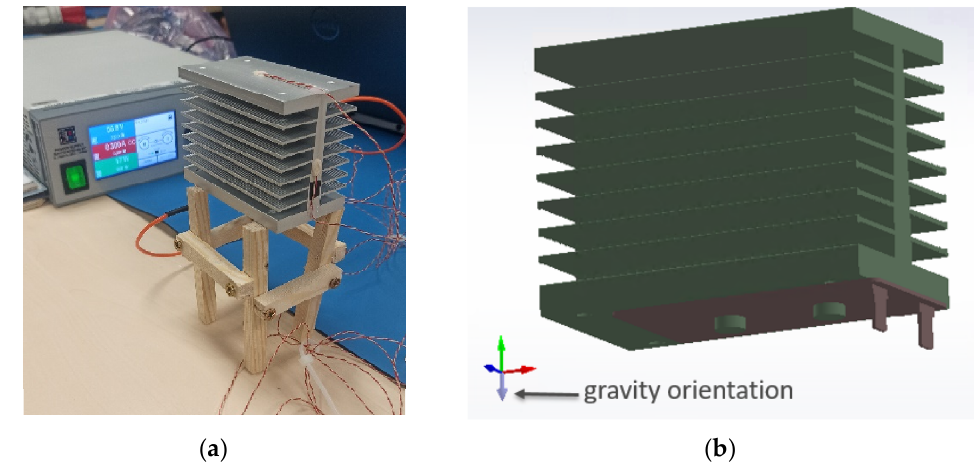
Figure 4. ( a ) Measurement of Setup 1; ( b ) Simulated model of Setup 1 and gravity orientation. Setup 2